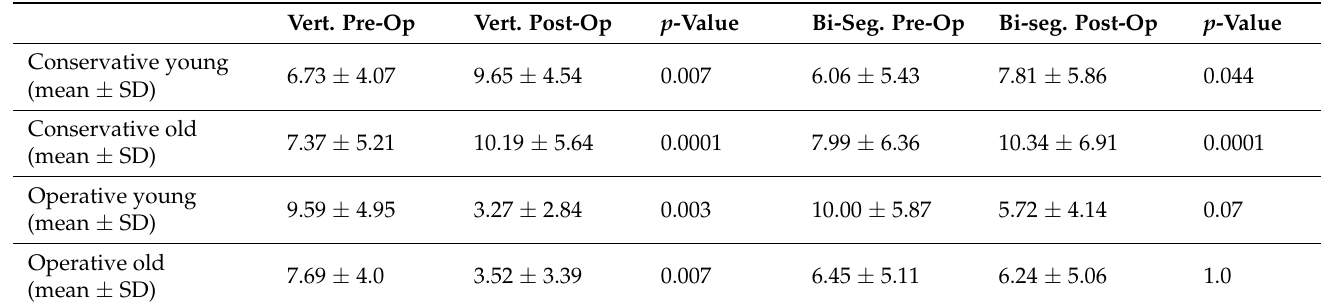
Table 2. Mean ± SD of kyphosis angles in grade, in both age groups, pre- and post-treatment and p -values of kyphosis angles pre- vs. post-treatment in both age groups.